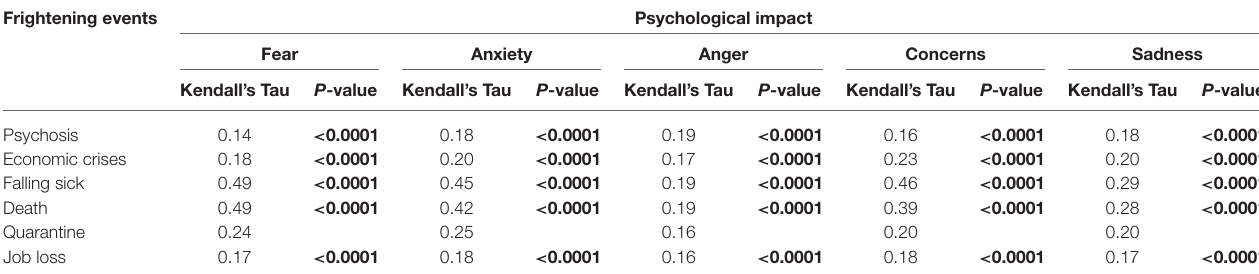
TABLE 7 | Correlations values (Kendall’s tau statistics) relating to “psychological impact and frightening events” categories. Frightening